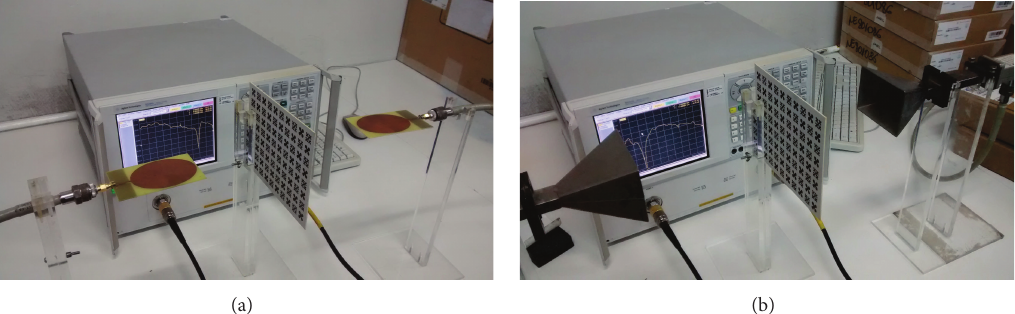
Figure 4: Photographs of the experimental setups: (a) setup #1 with elliptical monopoles and (b) setup #2 with horn